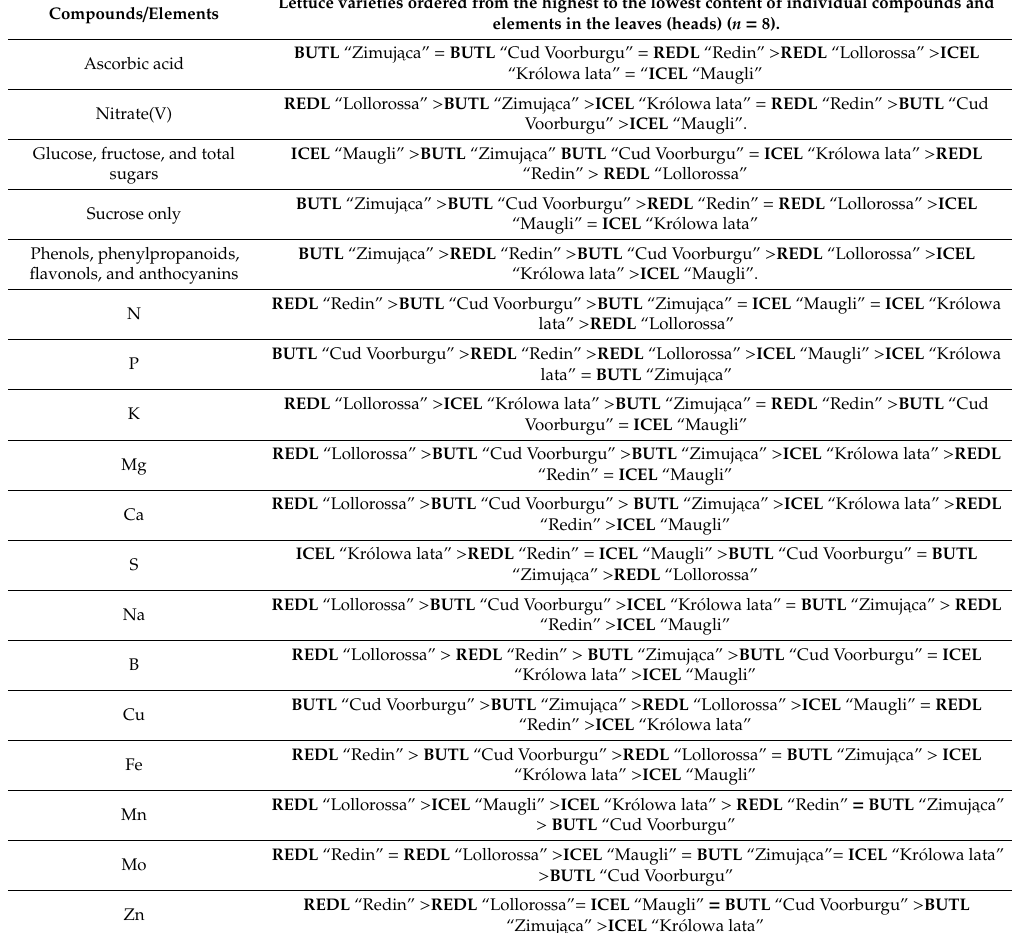
Table 1. The ordering of the lettuce varieties in terms of the level of the content of the compounds and the elements in the leaves (heads). BUTL—butterhead lettuce; ICEL—iceberg lettuce; REDL— Lactuca sativa L. var. crispa L. (red-leaved